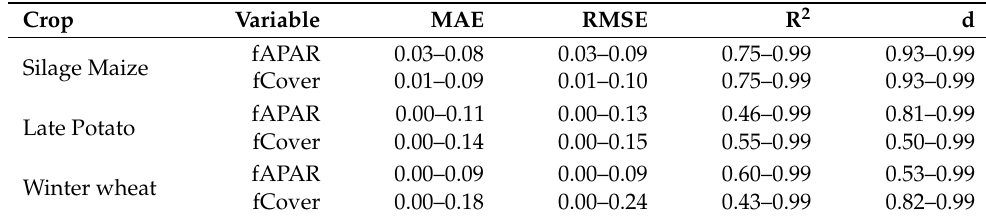
Table 3. Goodness-of-fit metrics for model fitting per field of DHP-derived fAPAR and fCover. Crop Variable MAE Silage